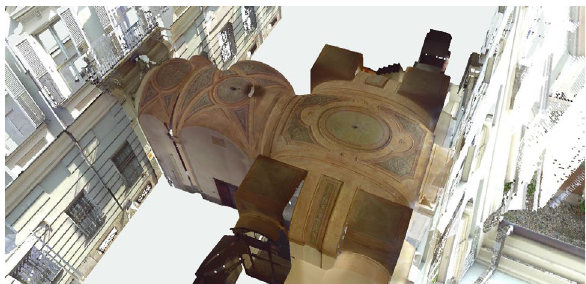
Figure 4 . Point cloud of the vaulted system of the Capris di Cigliè palace. The HDR of the cameras attached to the Focus 3D x 130 scanner provides colours close to reality (processing by C. López